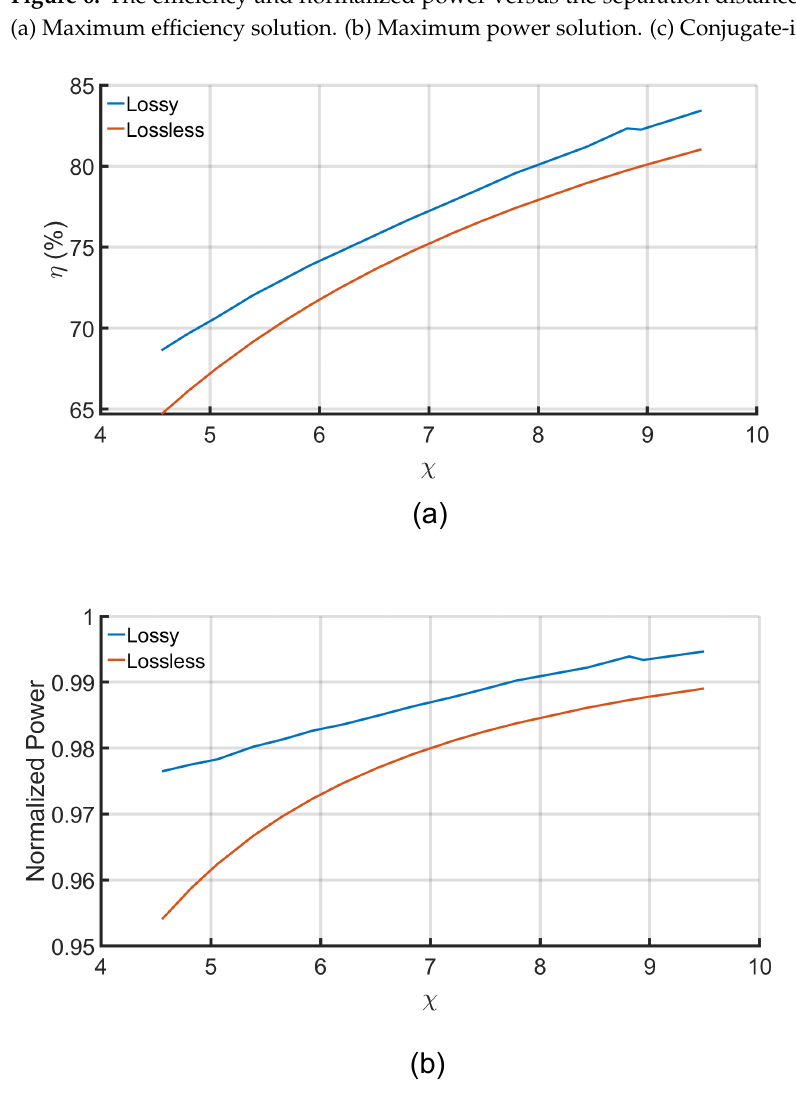
Figure 7. The efficiency and normalized power versus χ for lossy and lossless solutions: ( a ) Maximum efficiency solution. ( b ) Maximum power